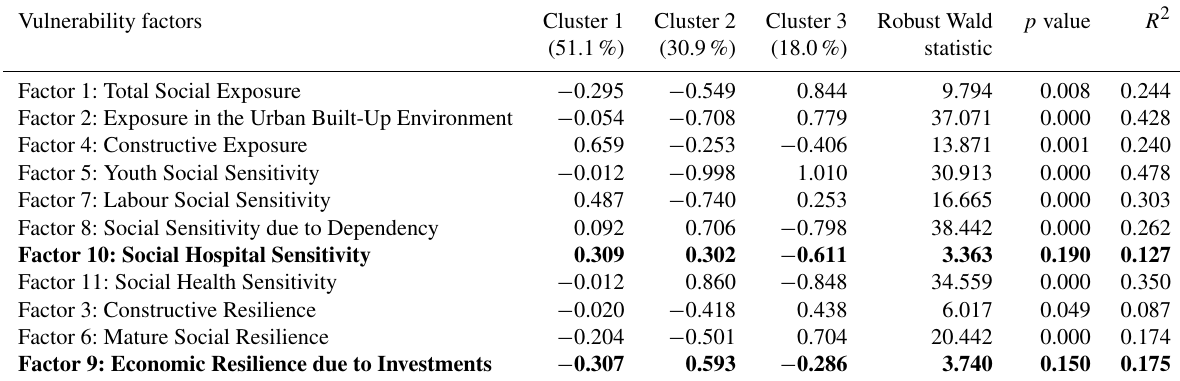
Figure 6. Characteristics of the urban areas that form the identified clusters. Bars with a meshed plot represent factors which were not statistically significant in the discrimination of clusters of urban areas. Bars are sorted by vulnerability component (exposure, sensitivity and resilience). Source: municipal boundaries (available online: http://www.ign.es; accessed on 5 December 2016). Table 4. Parameters of urban area clusters associated with vulnerability factors. Vulnerability factors are sorted by vulnerability component (exposure, sensitivity and resilience). Factors highlighted in bold were not statistically significant when discriminating among the three clusters of urban areas ( p > 0 .